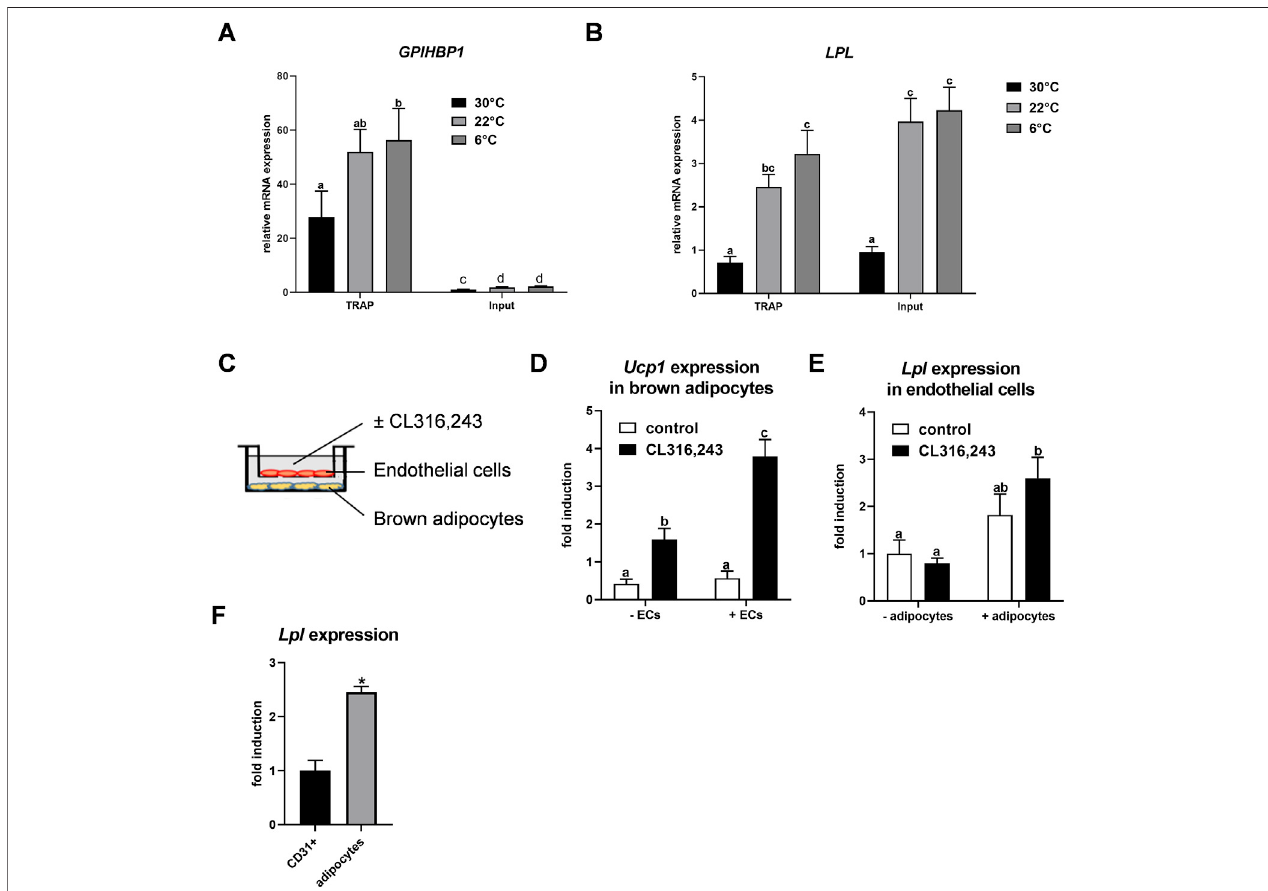
FIGURE1| EndothelialexpressionofLPLinBAT. (A – B) EndoNuTRAPmicewerehousedat22 ° C,at6 ° Corat30 ° Cfor3d.Expressionof Gpihbp1 (A) and Lpl (B) in endothelial cells (TRAP) and total tissue (input) of BAT were analyzed by qPCR (n = 4 – 5). (C) Transwell system for co-culturing of murine brown adipocytes with murine microvascularendothelialcells.Endothelialcellswerecultured inthepresenceorabsenceofdifferentiatedbrownadipocytesandwereincubatedwithoutorwiththe β 3- adrenergic agonist CL316,243 at the same time to thermogenically activate the brown adipocytes. (D) Ucp1 expression in brown adipocytes co-cultured without and with endothelial cells (ECs) (n = 4). (E) Lpl expression in endothelial cells co-cultured with brown adipocytes (+adipocytes) or without (-adipocytes), stimulated with CL316,243 or with vehicle (none) (n = 4). (F) Wild type mice were housed at 6 ° C for 3 days and expression of Lpl was determined in CD31-positive endothelial cells and thermogenic adipocytes of BAT that were isolated by MACS ® (n = 3)Results are presented as mean values ±SEM. Statistical signi fi cance for (A,B) was determined by one-way ANOVA and for (D,E) by two-way ANOVA. Same letter denotes groups that are not signi fi cantly different from each other ( p ≥ 0.05). Statistical signi fi cance for (F) was determined by Student ’ s t test; * p <